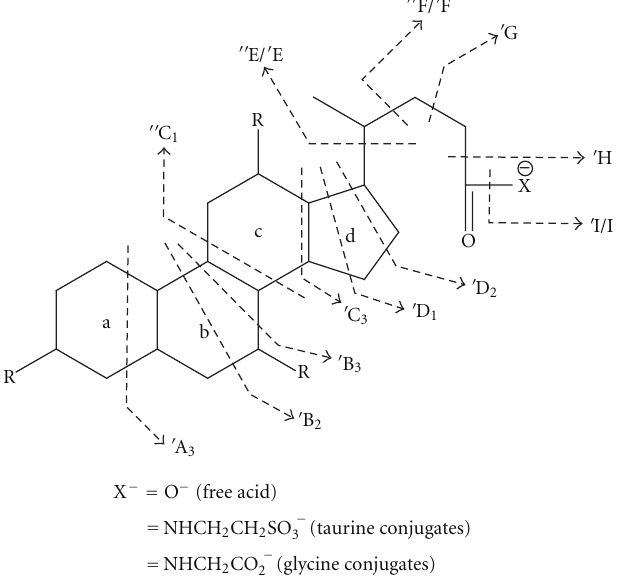
Figure 22: The charge remote fragmentation of bile acids (metabolites of cholesterol) with the nomenclature of di ff erent fragments.